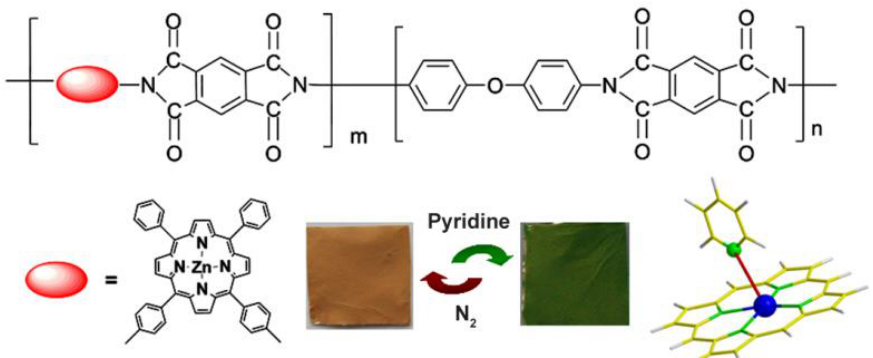
Figure 1. Molecular structure of ZPCPI used in this study and the schematic illustration for the whole vapochromic and spectrophotometric detection of pyridine